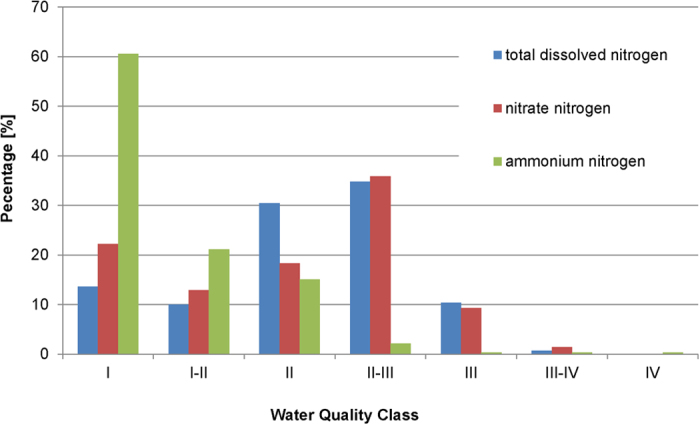
Frequency distribution [%] of samples per water quality class (for water quality class definitions, see Methods).